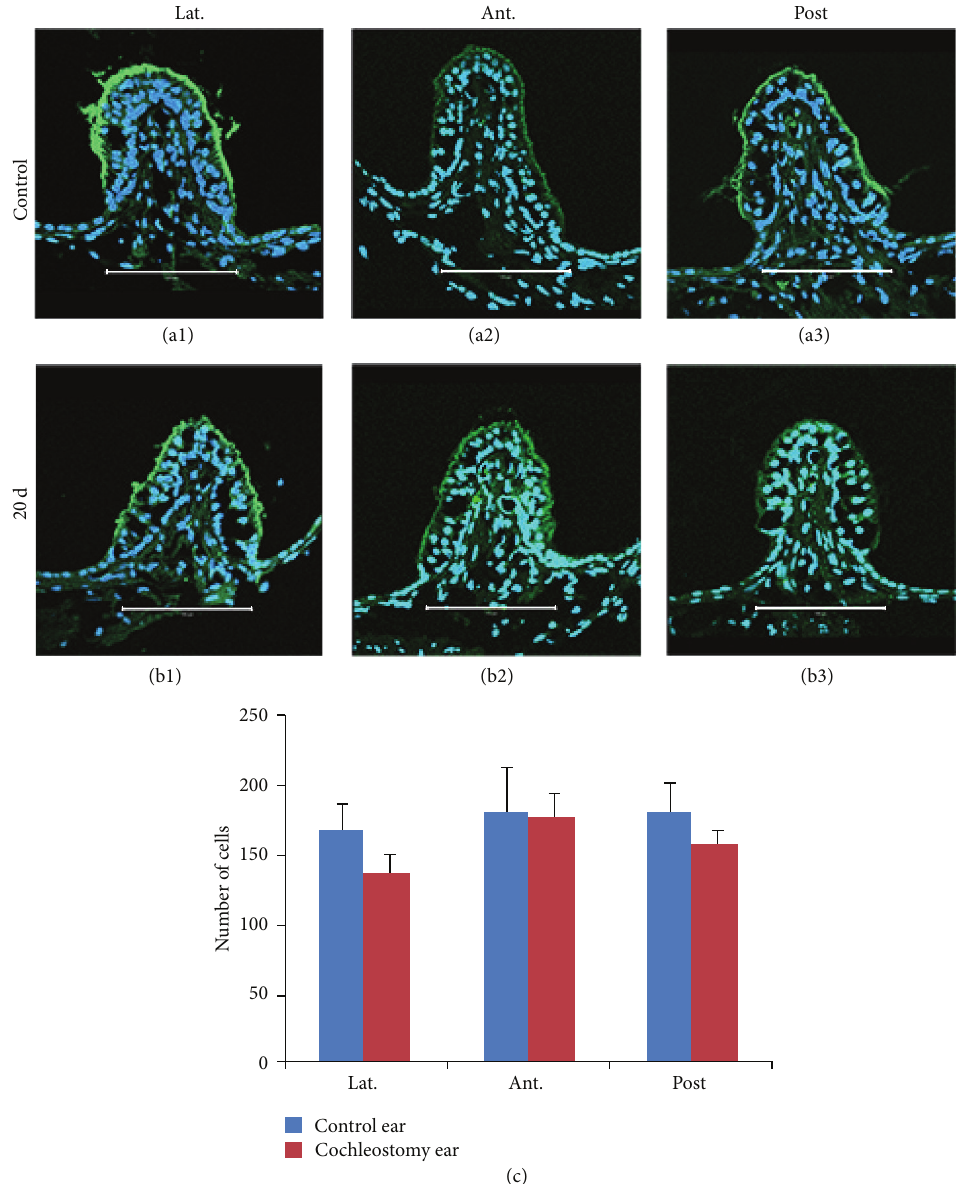
Figure 4: Cryosectional histopathologic findings and hair cell counts of semicircular canal ampullae in normal (a1, a2, and a3) and cochleostomy (b1, b2, and b3) ears at 20 days, stained with phalloidin (green) and DAPI (blue). Although the number of hair cells was slightly reduced in the lateral and posterior semicircular canal ampullae after cochleostomy, no significant differences in hair cell counts were observed between the cochleostomy and normal ears (c). (a1) and (b1): lateral canal ampulla; (a2) and (b2): anterior canal ampulla; (a3) and (b3): posterior canal ampulla. Scale bar = 100 𝜇